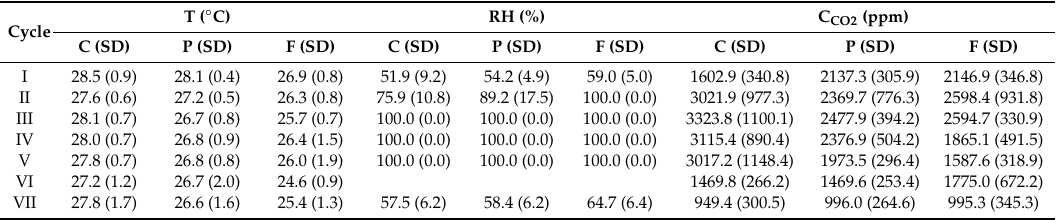
Table 2. Mean and standard deviation (SD) values for environmental variables in the animal zone during the critical, postcritical and final periods.